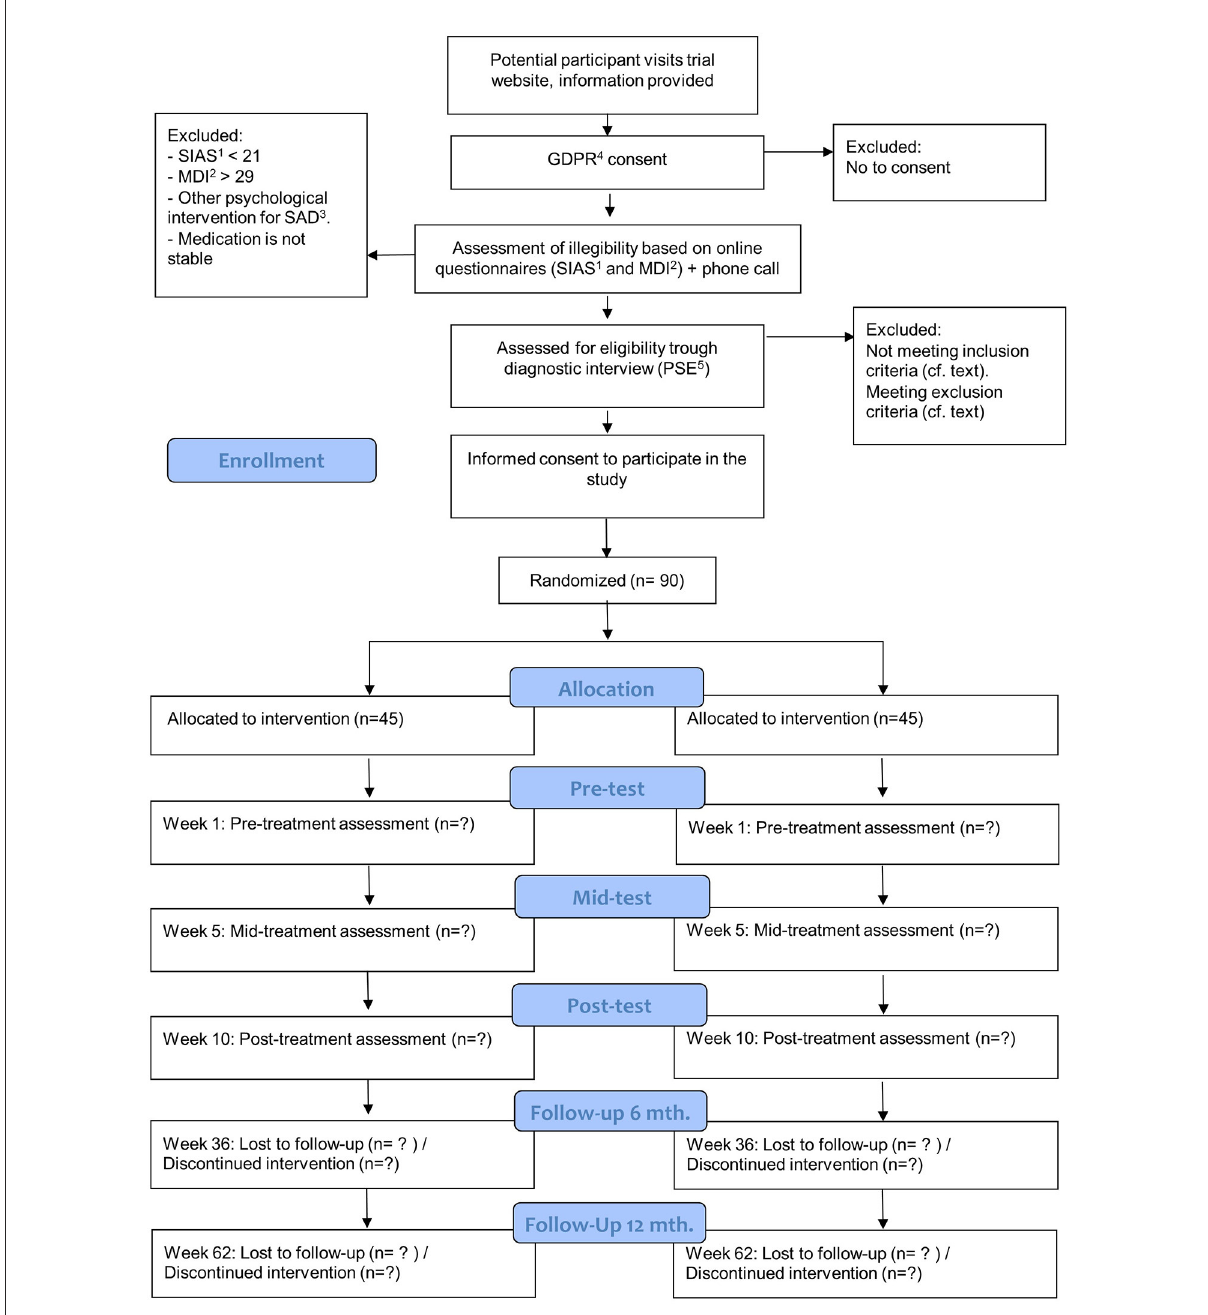
FIGURE1 Flowchart for inclusions, interventions, and assessments. 1 SIAS, Social Interaction Anxiety Scale; 2 MDI, Major Depression Inventory; 3 SAD, Social Anxiety Disorder; 4 GDPR, General Data Protection Regulation; 5 PSE, Present State